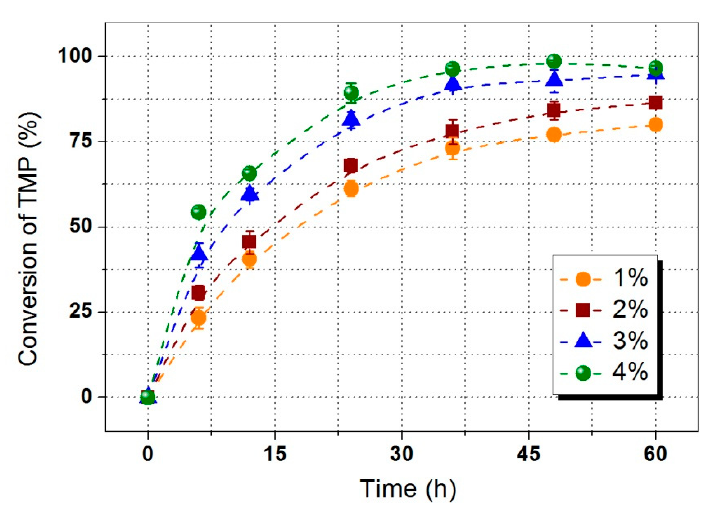
Figure 4. In fl uence of enzyme amount for TMP ‐ tri ‐ LA ester synthesis. Figure 4. Influence of enzyme amount for TMP-tri-LA ester